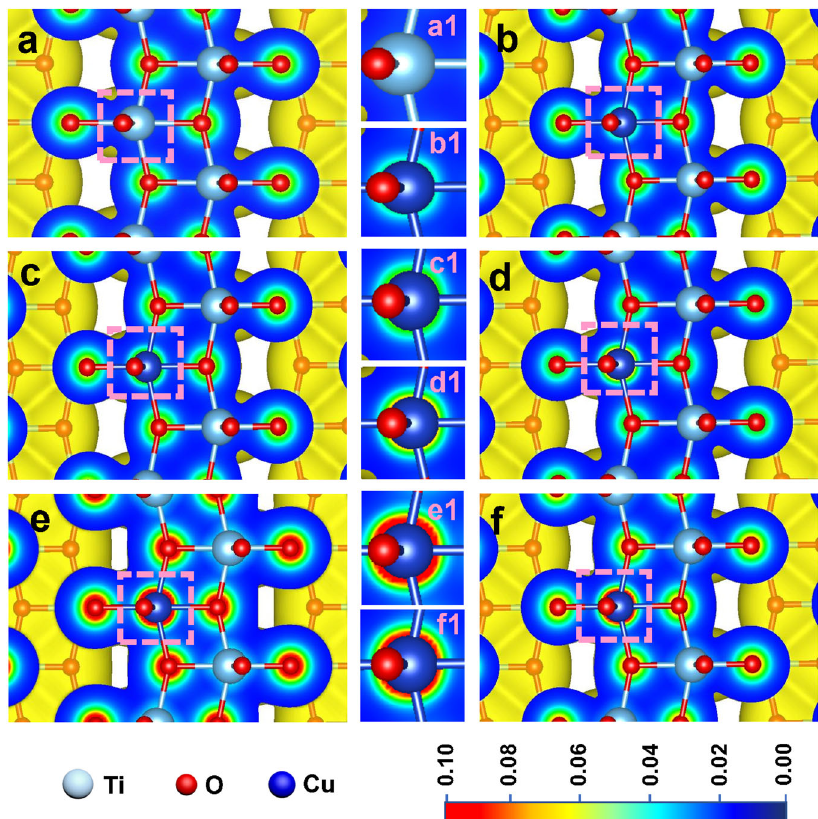
Fig. 4 Charge density distribution with or without irradiation. a Charge density distribution of pure TiO 2 . b CuSA-TiO 2 under dark condition (Cu is in the dotted square). c CuSA-TiO 2 after 100 ps irradiation. d CuSA-TiO 2 after 200 ps irradiation. e CuSA-TiO 2 after 1 ns irradiation. f CuSA-TiO 2 after turning off the irradiation for 100 ps. In the middle panel, ( a 1 – f 1) is the magni fi ed Cu atom highlighted by pink square in ( a – f ). Black and red colored circles indicate more electrons ’ accumulation on